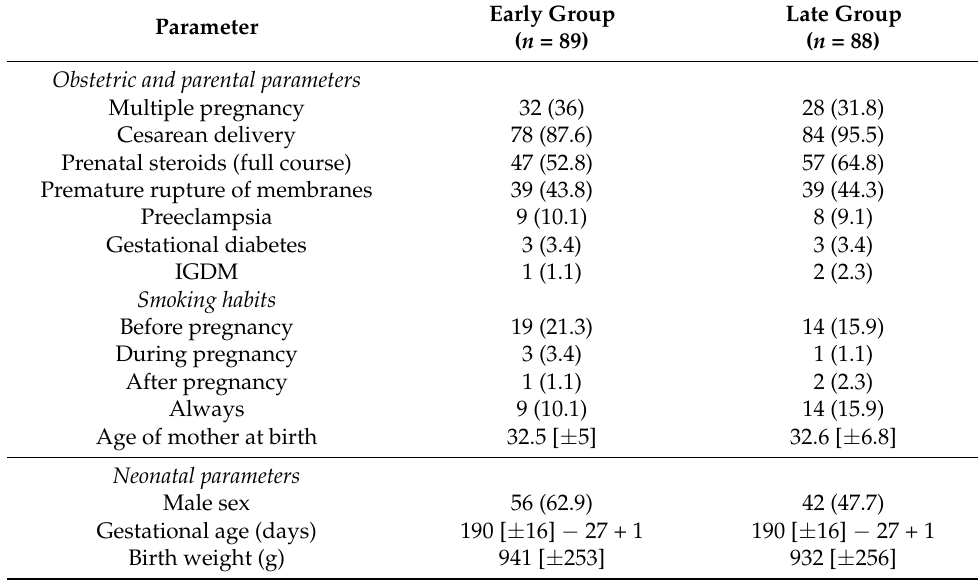
Table 1. Baseline characteristics and neonatal